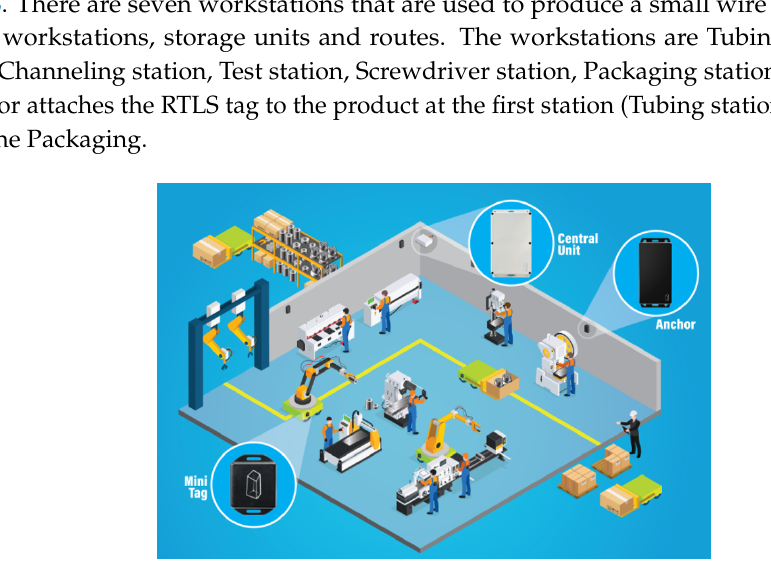
Figure 8. The infrastructure of the Sunstone-RTLS. Every central unit (CU) has eight anchors (which collect data from tags), and the CUs can be connected to create a cascade installation.